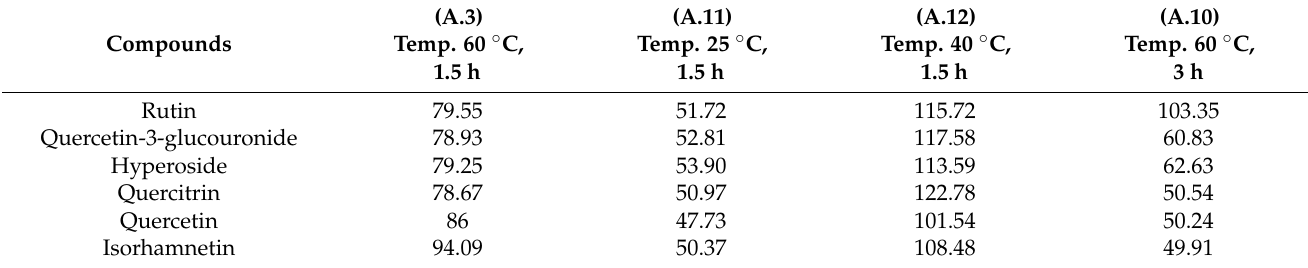
Table 7. Recovery percentages ( n = 2) at different temperatures and the time of extraction for acidic hydrolysis of EtOH 70% at pH 2